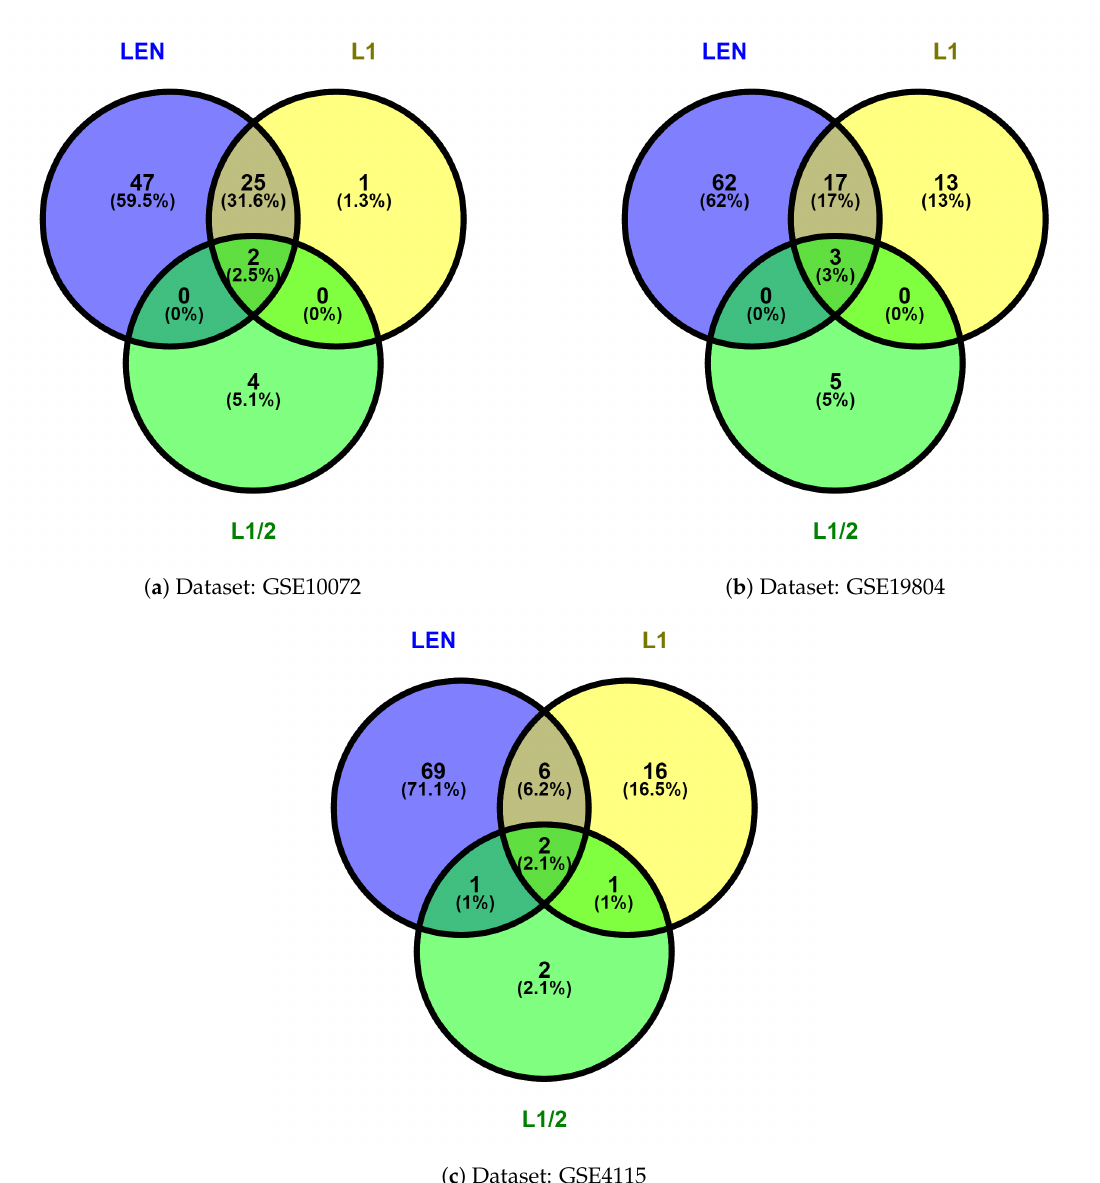
Figure 2. Venn diagram analysis of the results of L 1 , L EN , and L 1/2